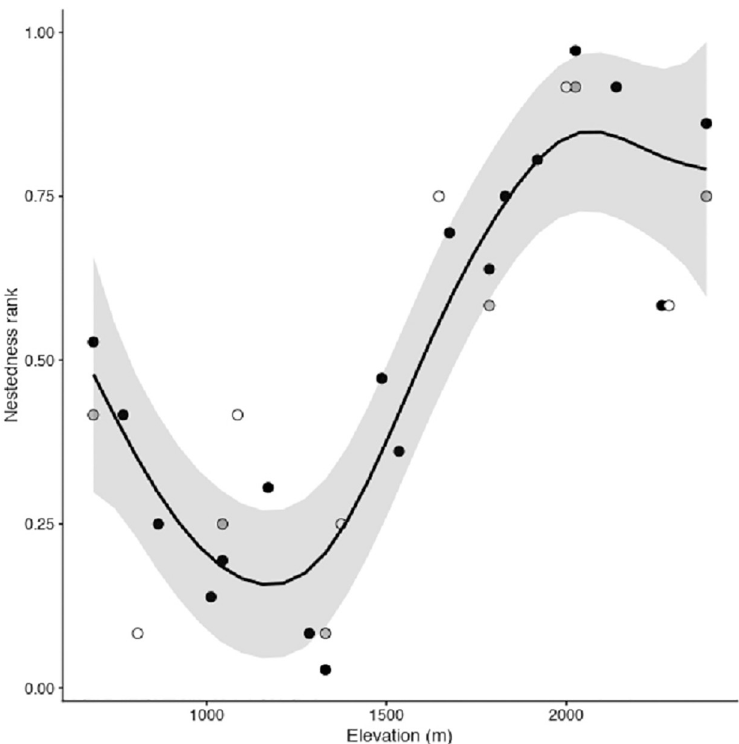
Fig 4. Generalized additive model (GAM) of nestedness ranks (based on nestedness temperature (T) index) for elevation in ant species assemblages in dry grasslands of a Mediterranean range in central Spain. Curve and 95% IC from GAM with Gaussian errors fit to the Guadarrama 2014 survey (black circles). Nestedness ranks for the Guadarrama 2015 (grey circles) and Serrota 2015 (open circles) surveys are superimposed. Low ranks indicate poorer species community richness, where species are a subset of richer species communities. Elevation values were slightly jittered to avoid overlap among some points.